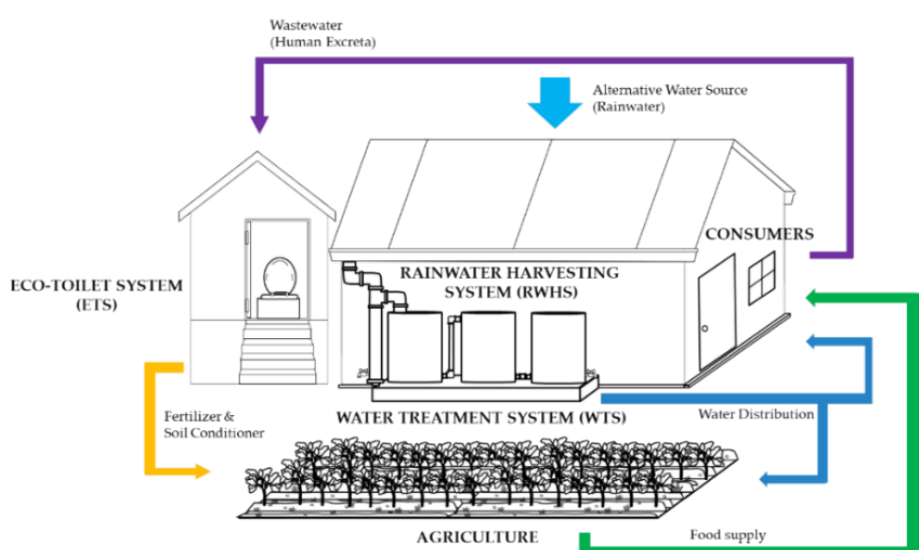
Figure 1. Design of the Integrated Water System (IWS).